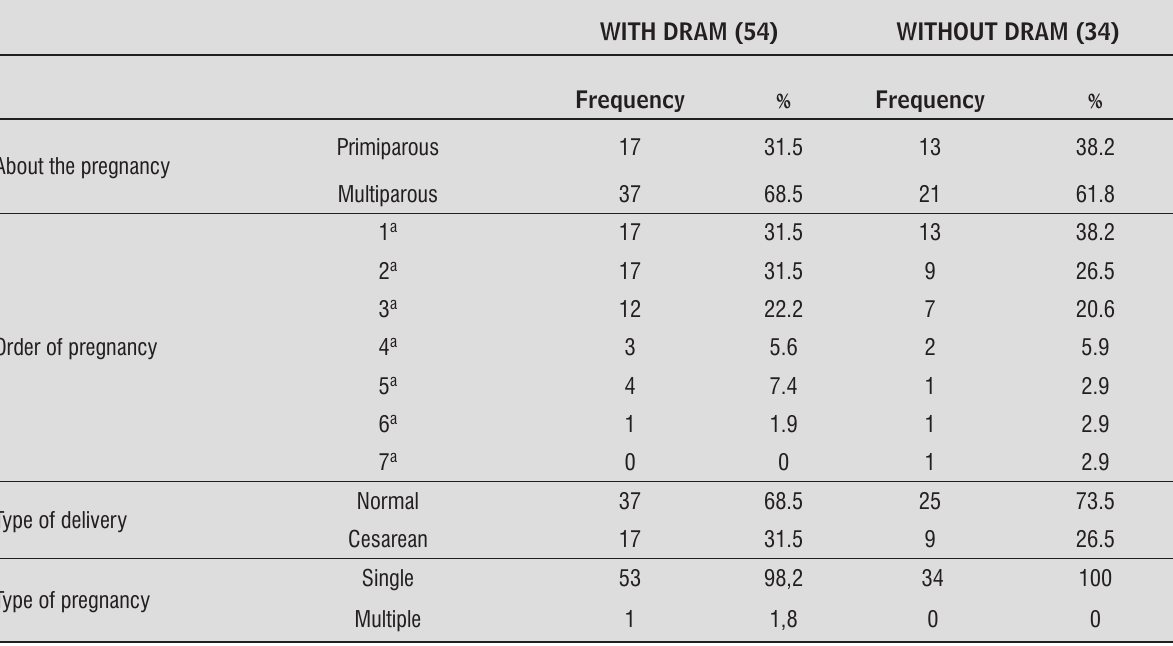
Table 2 - Data concerning the participants’ reproductive histories, according to the presence or absence of DRAM,